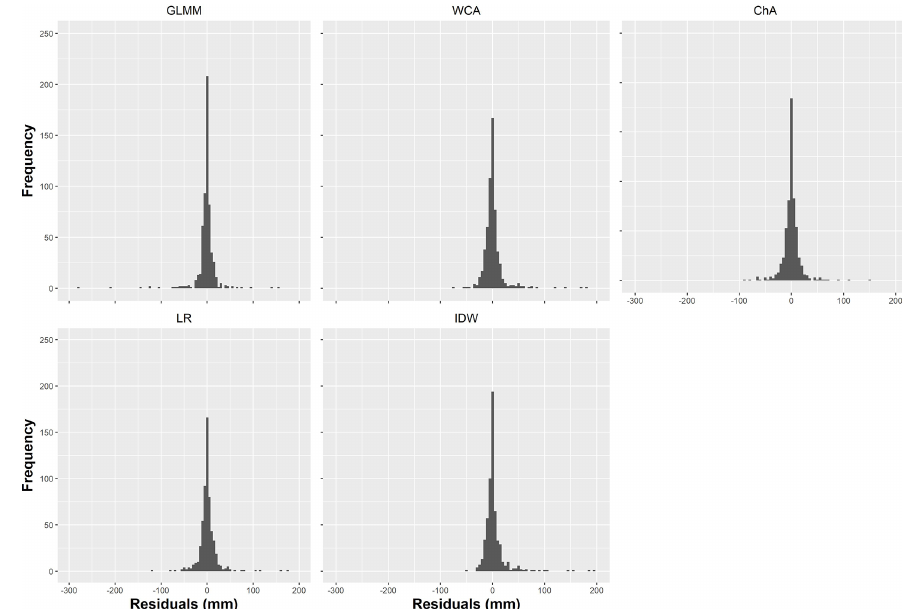
Figure 9. Residuals of the precipitation LOOCV for each interpolation